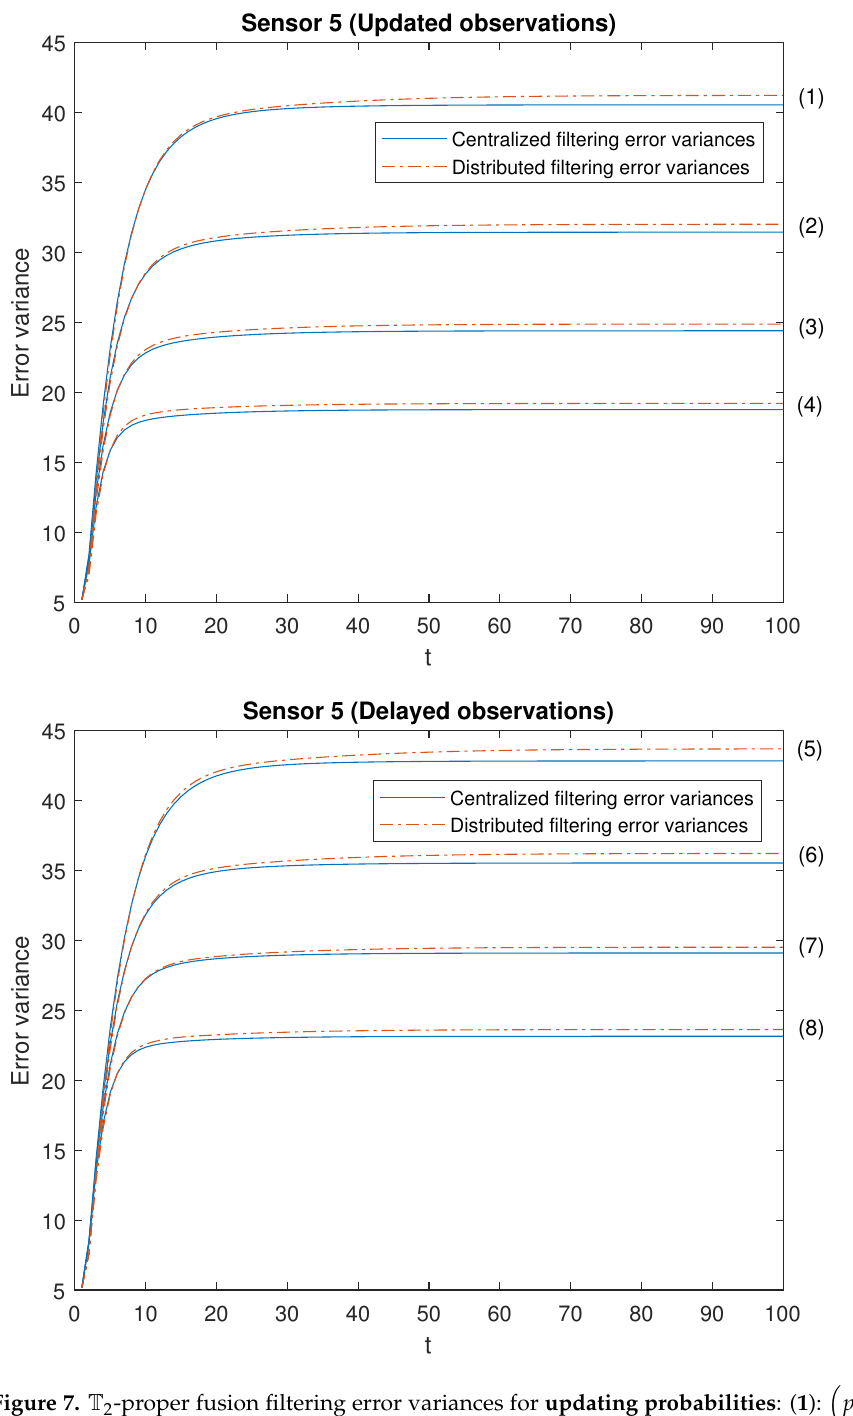
Figure 7. T 2 -proper fusion filtering error variances for updating probabilities : ( 1 ): ( 0.3,0.2 ) ; ( 2 ): delay probabilities : ( 5 ): ( 0.7,0.6 ) ; ( 8 ):